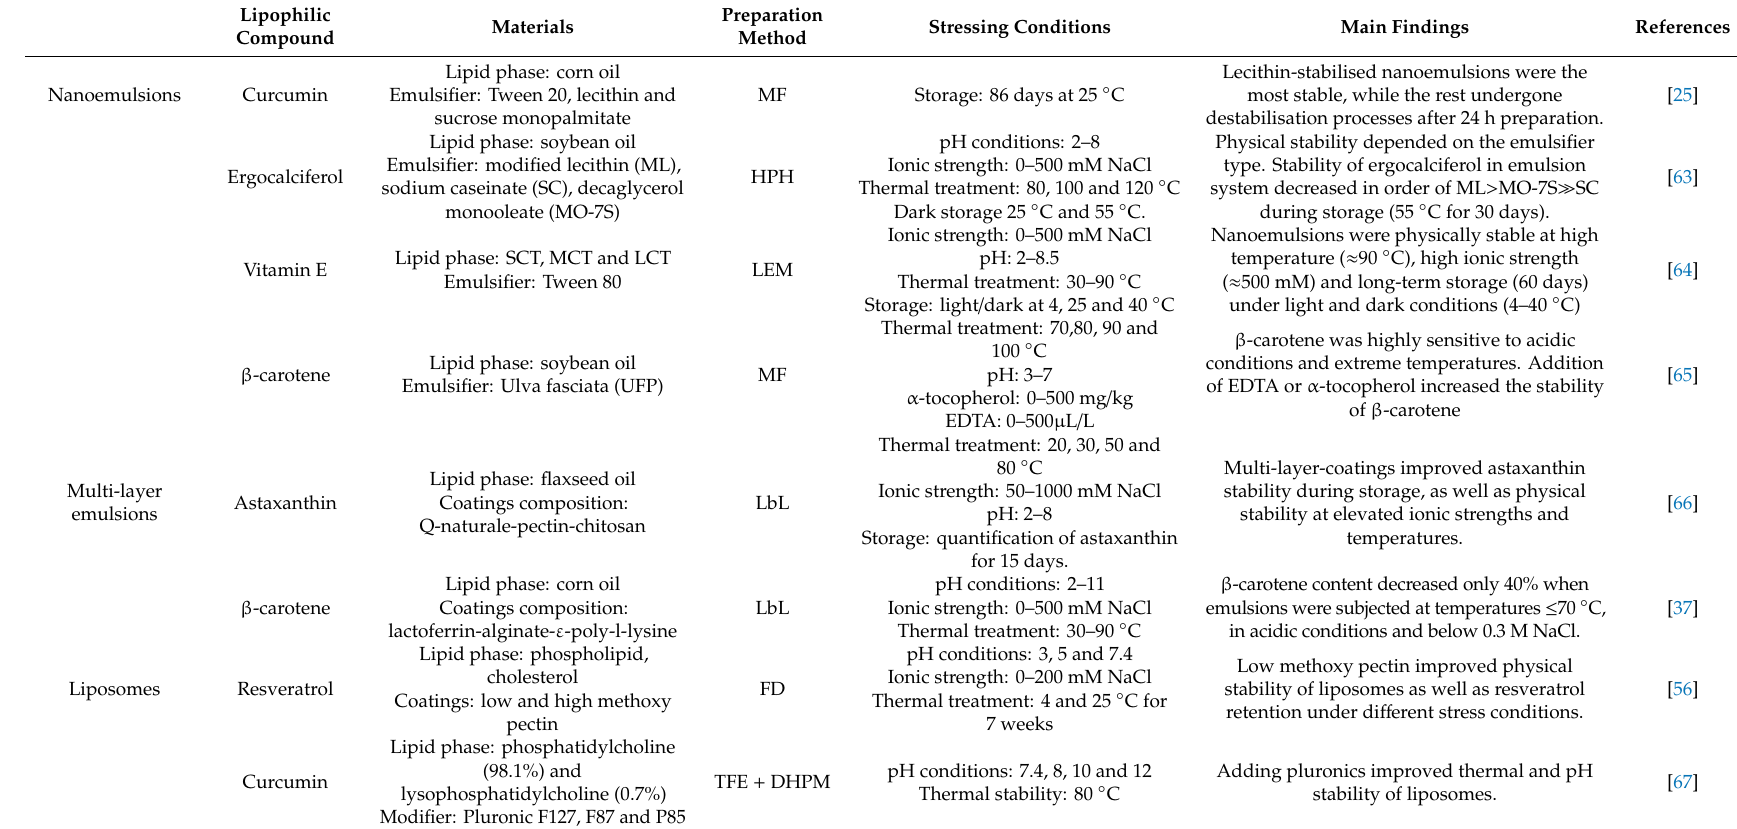
Table 1. Recent studies about stability of nanostructured lipid-based delivery systems under di ff erent stressing